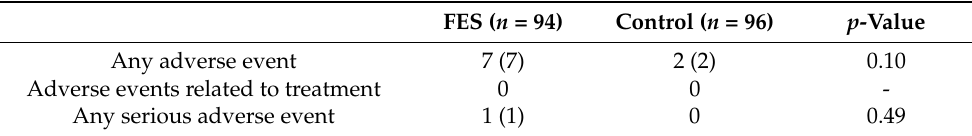
Table 3. Adverse events. Data are presented as n (%). FES ( n = 94) Control ( n = 96) p